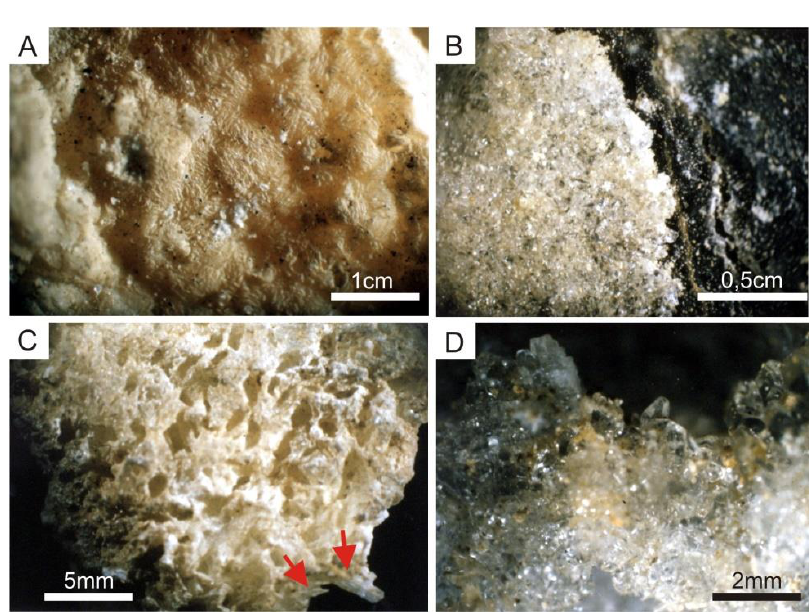
Figure 4. Speleothems related to cave paintings. ( A ) Surface view of calcite speleothem (1st phase speleothems). ( B ) Calcite speleothem lining partially filled fissure. ( C ) Gypsum crust (2nd phase speleothems) with euhedral tabular crystals (highlighted by the arrows). ( D ) Gypsum aggregate formed by subhedral crystals.